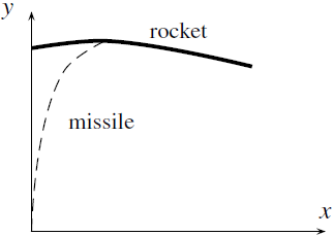
Figure 3. Interception